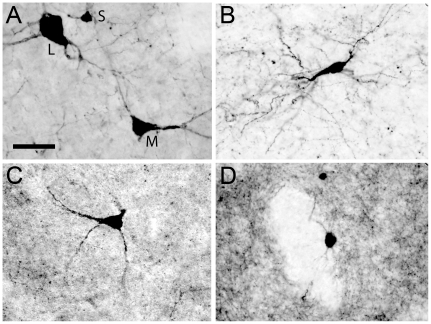
Photomicrographs showing the populations of interneurons included in the study.A, CR-ir (S, small, M, medium, L, large); B, PV-ir; C, CB-ir; and D, TH-ir cells. Calibration bar: 40 µm for all images.